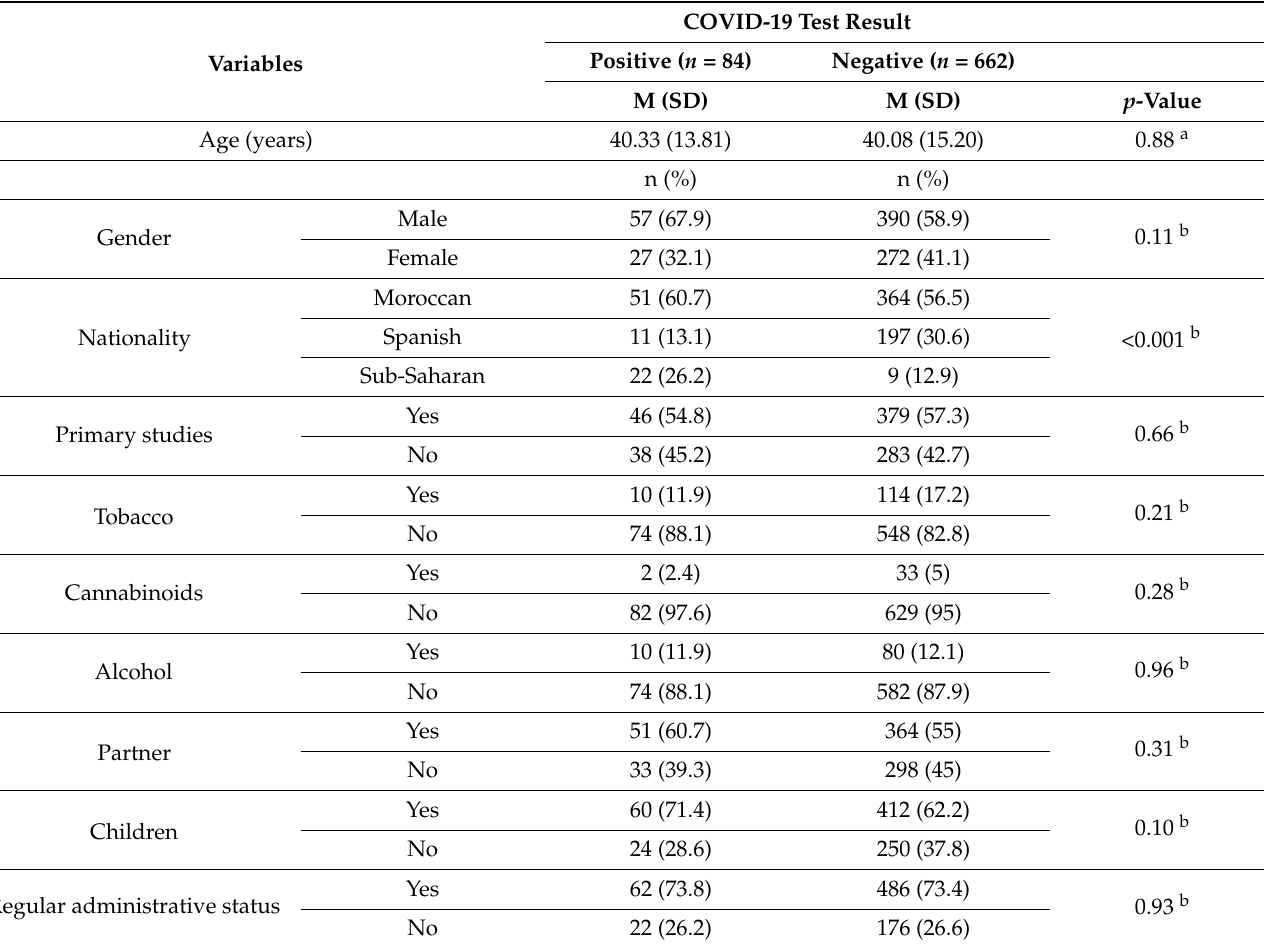
Table 1. Analysis of sociodemographic variables among COVID-19 positive and negative